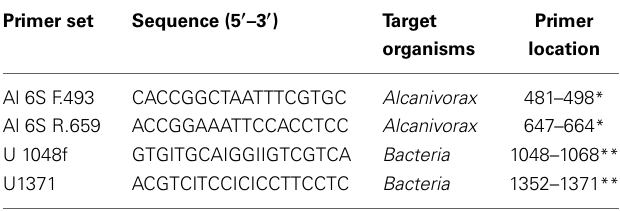
Table 1 | Oligonucleotides primers used in qPCR